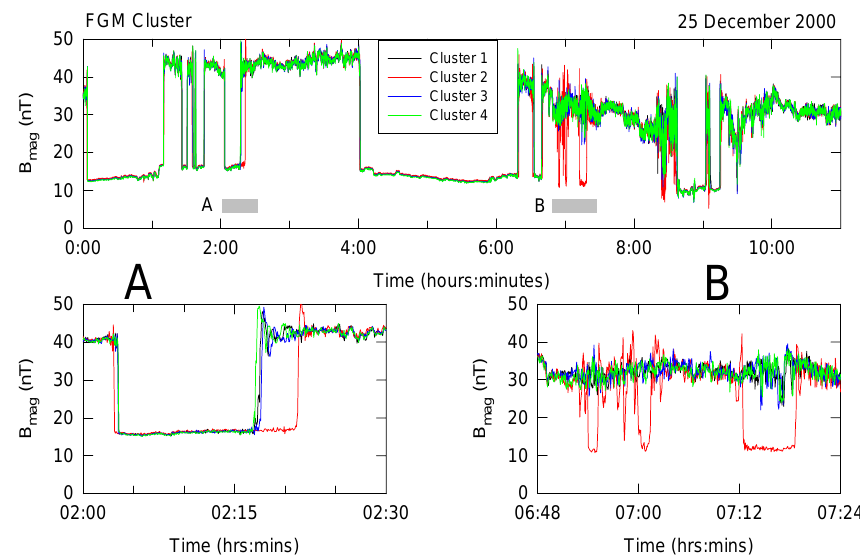
Fig. 10. An overview of the multiple crossings of the bow shock by Cluster on 25 December 2000, with two intervals shown in higher resolution to illustrate the motion and dynamics of the bow shock observed by